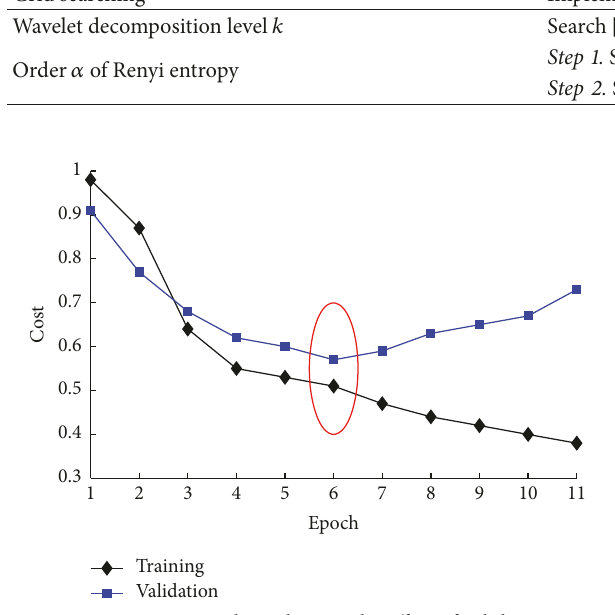
Figure 7: A toy example explaining the effect of validation